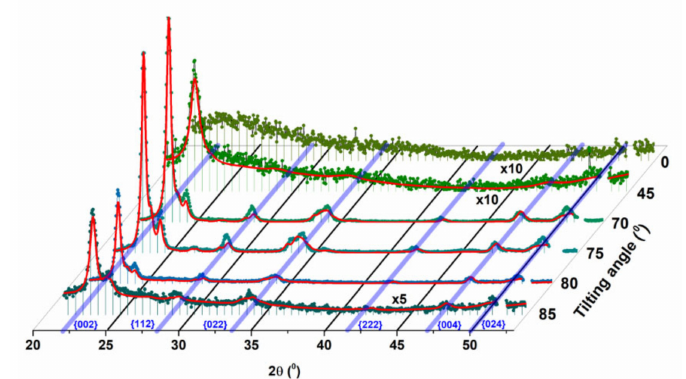
Figure 2. Di ff raction patterns of WO 3 thin film samples. The green points are data points and red lines are the fits. Blue longitudinal lines show approximated positions of most intensive {hkl} family planes. The patterns intensity were multiplied by 10 for samples S0 and S45 while for S85 by 5.